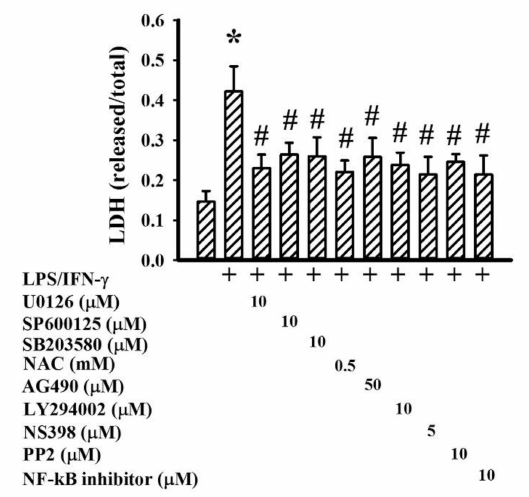
Figure 11. Pharmacological inhibitors alleviated neuronal cell death. Neuron/glia cultures were pretreated with vehicle, U0126 (10 µ M), SP600125 (10 µ M), SB203580 (10 µ M), NAC (0.5 mM), AG490 (50 µ M), LY294002 (10 µ M), NS398 (5 µ M), PP2 (10 µ M), or NF-kB inhibitor (10 µ M) for 30 min. before being incubated with LPS (100 ng/mL)/IFN- γ (10 U/mL) for an additional 48 h. Cell damage was measured by LDH efflux assay. * p < 0.05 vs. untreated control and # p < 0.05 vs. LPS/IFN- γ control, n = 4. The + means the groups treated with LPS/IFN- γ and the rest groups without + indicate vehicle treatment.